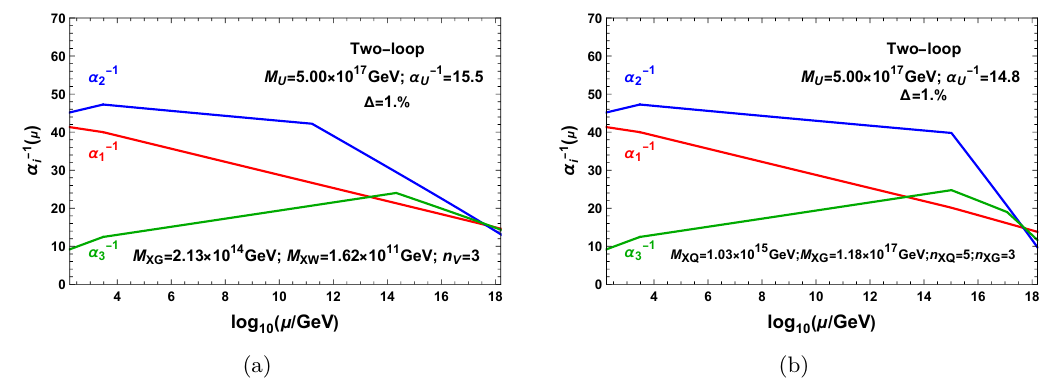
Figure 5 . Two-loop evolution of gauge couplings for the Model 5 with vector-like particles. In the model, k = 10 × 5 and k = 2 . The string-scale gauge coupling relations can be achieved by Y 2 7 3 3 adding 3( XW + XG ) (a) and 5( XQ + XQ ) + 3 XG